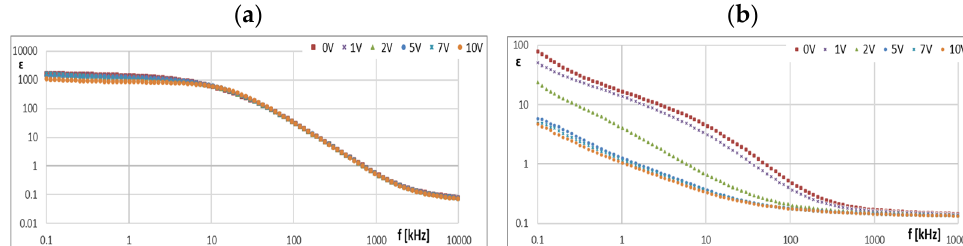
Figure 12. The results of the first measurement ( a ) and second (next) measurement ( b ) dependence of